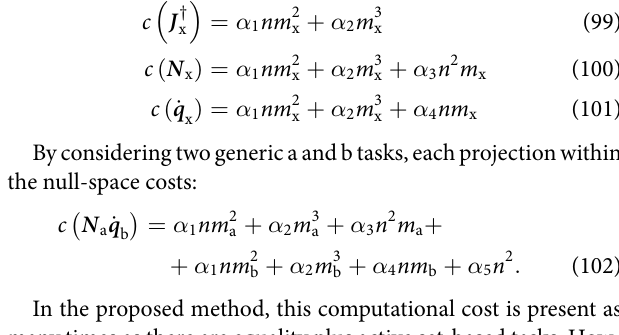
TABLE 3 | Table illustrating the activation of mode based on the Boolean variables as defined in equation (98) . Priorities ( i )